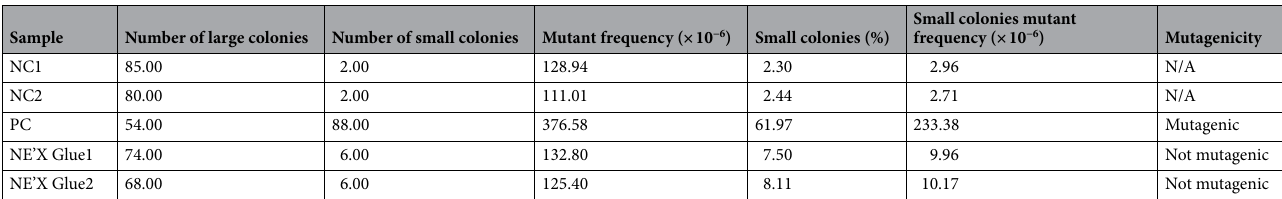
Table 10. Mutagenicity data, 4 h exposure, with metabolic activation. NC negative control, PC positive control.